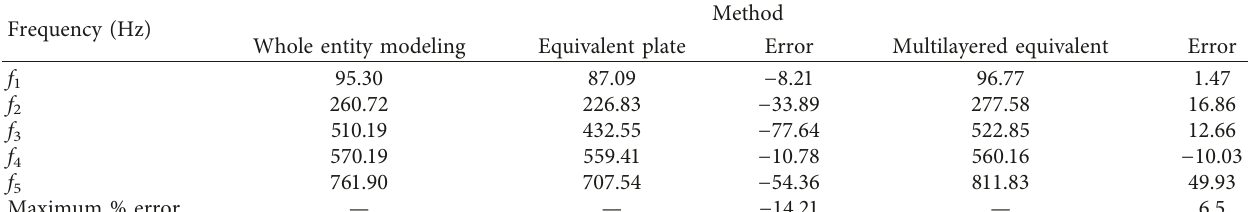
Figure 8: Constraints. Table 1: Natural frequency.